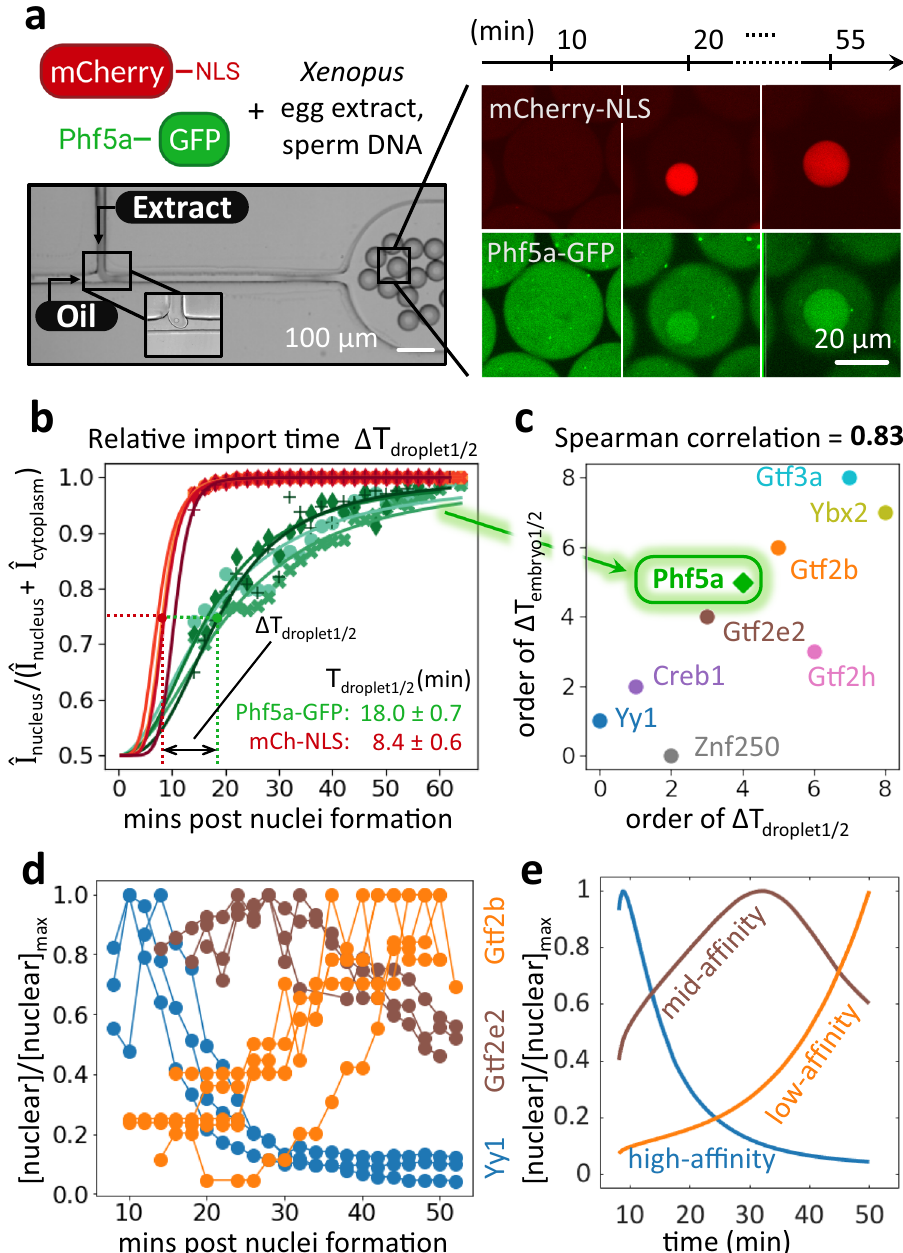
Fig. 5 | The temporalorder ofnuclear import in cell-freedroplets observed via imaging recapitulates the nuclear entry order observed in the embryo pro- teomic assay. a Left: Imaging of nuclear import in cell droplets. Xenopus egg extract doped with sperm DNA, which initiates the formation of nuclei, and GFP- tagged protein of interest (here Phf5a ) and mCherry-NLS were encapsulated in oil droplets with a micro fl uidic device. Right: We monitored nuclear import kinetics via fl uorescence microscopy. b We quanti fi ed the relative fl uorescent signal intensity I inthenucleusandcytoplasmand fi tthedatawithasigmoidtoextractthe time ( T droplet1/2 ) at which the relative intensity reaches half of its max value. To overcome extract variability, we calculate the import time difference ( Δ T droplet1/2 ) between mCherry-NLS and the protein of interest. Markers represent the raw measurements. The different symbols represent different droplets; lines are sig- moid fi ts of corresponding droplets. From these experiments, we extract the